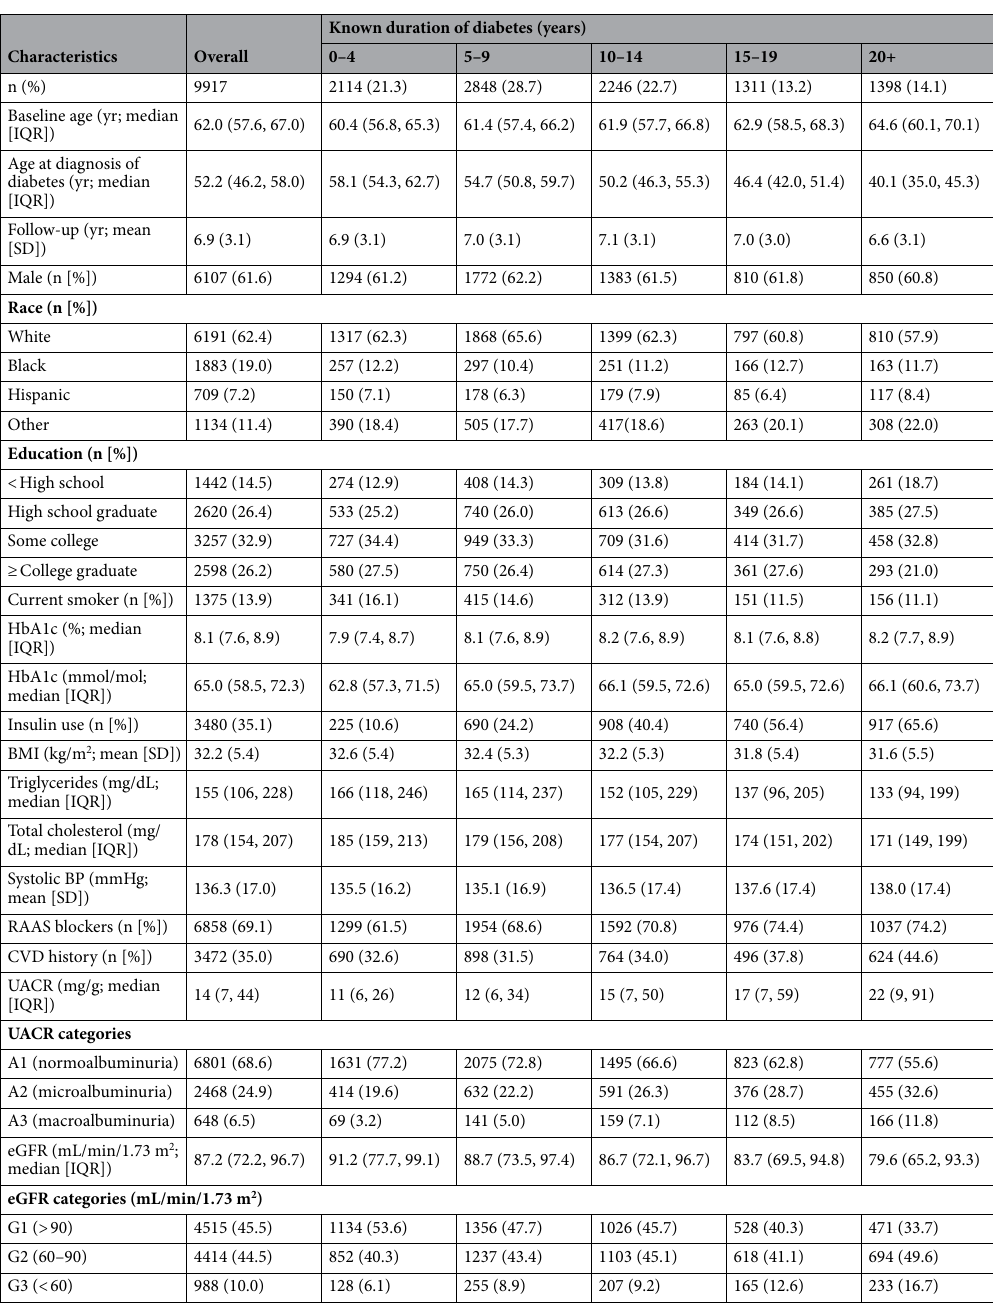
Table 2. Baseline characteristics of study participants according to known duration of diabetes. IQR interquartile range, y year-olds, yr year, HbA1c glycated haemoglobin, BMI body mass index, BP blood pressure, RAAS blockers renin–angiotensin–aldosterone system blockers, CVD history cardiovascular disease history, UACR urine albumin-creatinine ratio, eGFR estimated glomerular filtration